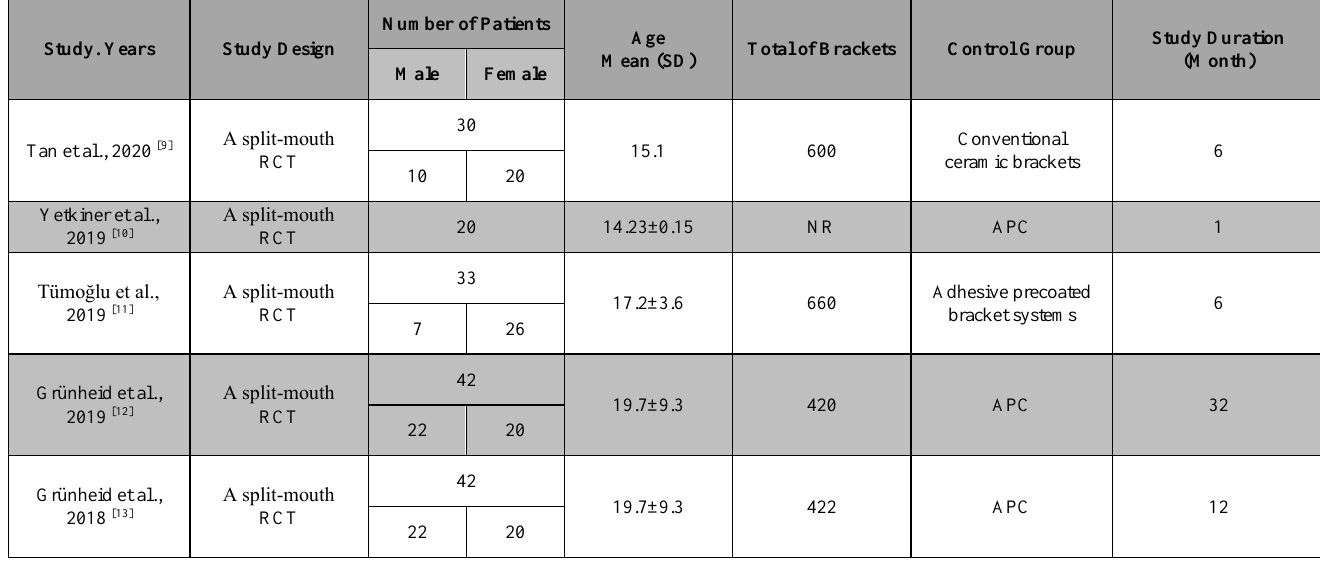
Table 2. Data extracted from selected studies.